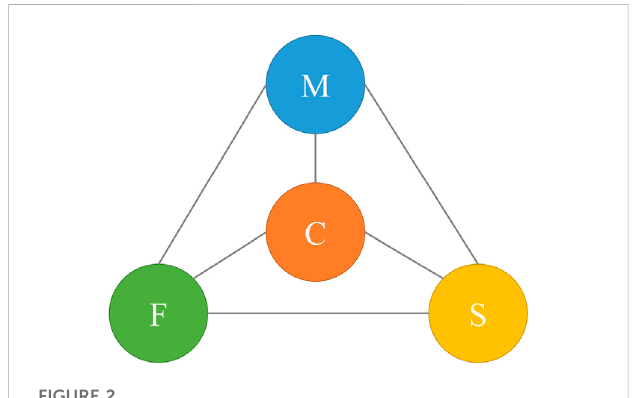
FIGURE 2 Schematic diagram of global platinum supply network